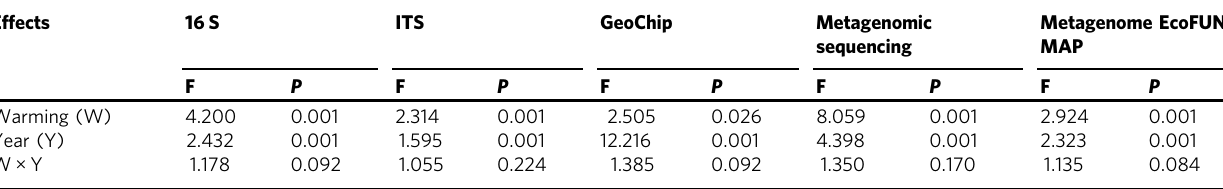
Table 1 Signi fi cance tests of the effects of warming and time on microbial community structures with permutational multivariate analysis of